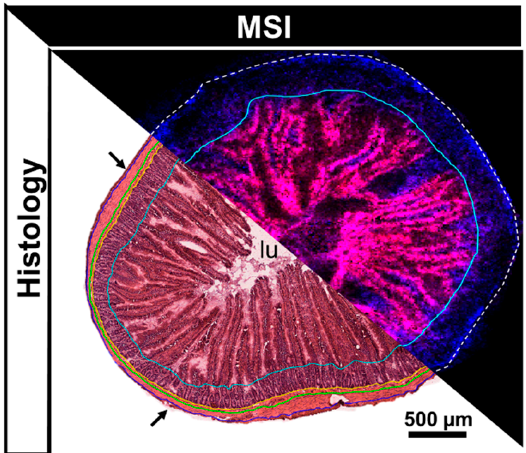
Figure 1. Annotated H&E scan compared to combined ion image obtained from an adjacent tissue section analyzed by MALDI-MSI (endogenous lipids PC (34:2) [M+K] + ( m/z 796.53) (red) and PC (34:1) [M+K] + ( m/z 798.54) (blue). Histological annotation on the H&E stained tissue: arrows = serosa, outside blue line = outer muscularis, between blue and green line = inner muscularis, between green and yellow line = submucosa, between yellow and turquoise line = mucosal crypts, within turquoise line = mucosal villi and intestinal lumen (lu).